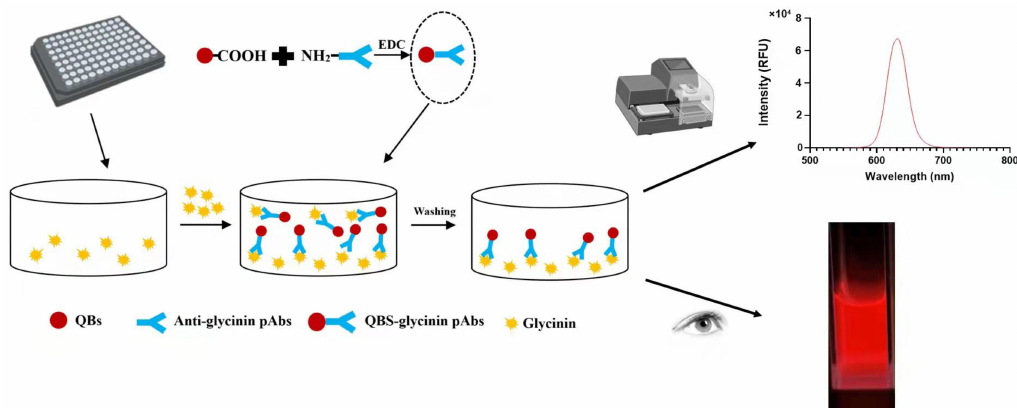
Figure 1. The working principle of QBs-based FLISA for glycinin